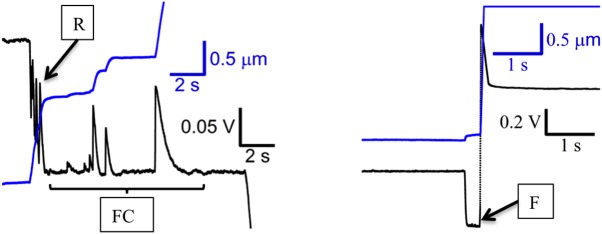
Classification of tether extension event types.Traces show Vdefl (black) and zservo (blue). FC (force clamp) events occur after Vdefl setpoint is reached. R (rapid) events occur before the Vdefl setpoint is reached. F events occur when the tip dissociates fully from the surface.